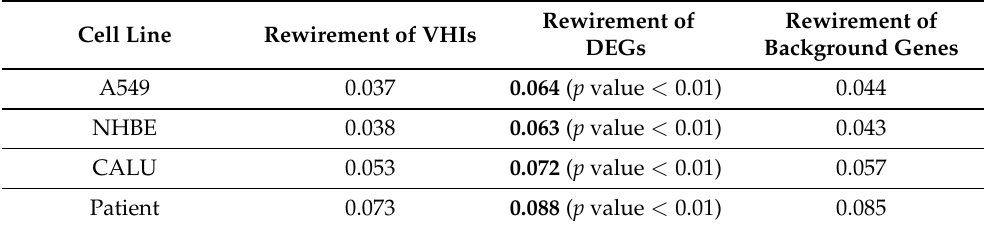
Table 3. Only DEGs were significantly rewired between control and infected iCells. For each cell line and the patient data (column 1), we computed the average rewiring of VHIs (column 2), DEGs (column 3) and background genes (column 4). We compare the rewiring of the VHIs and the DEGs with the background genes, and the entries are statistically significant are in bold (the corresponding p -value of the Mann–Whitney test is in